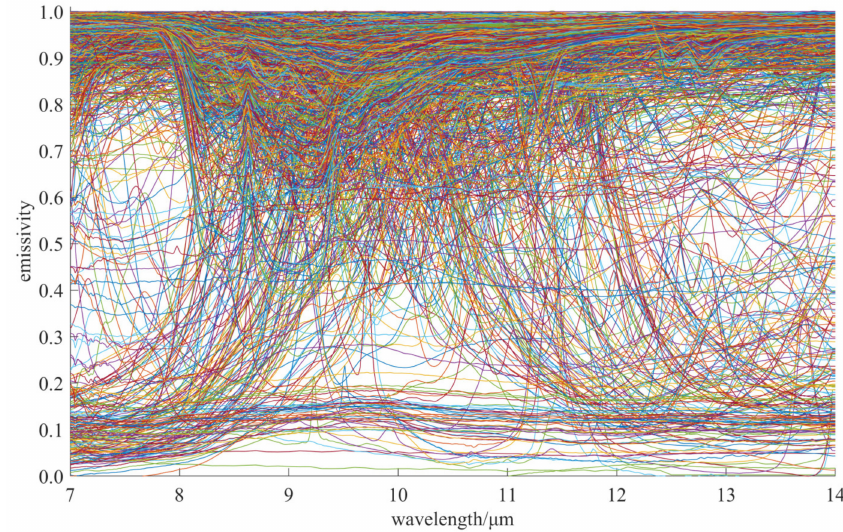
Figure 2. The 1525 emissivity curves from ASTER 2.0 Spectral Library.